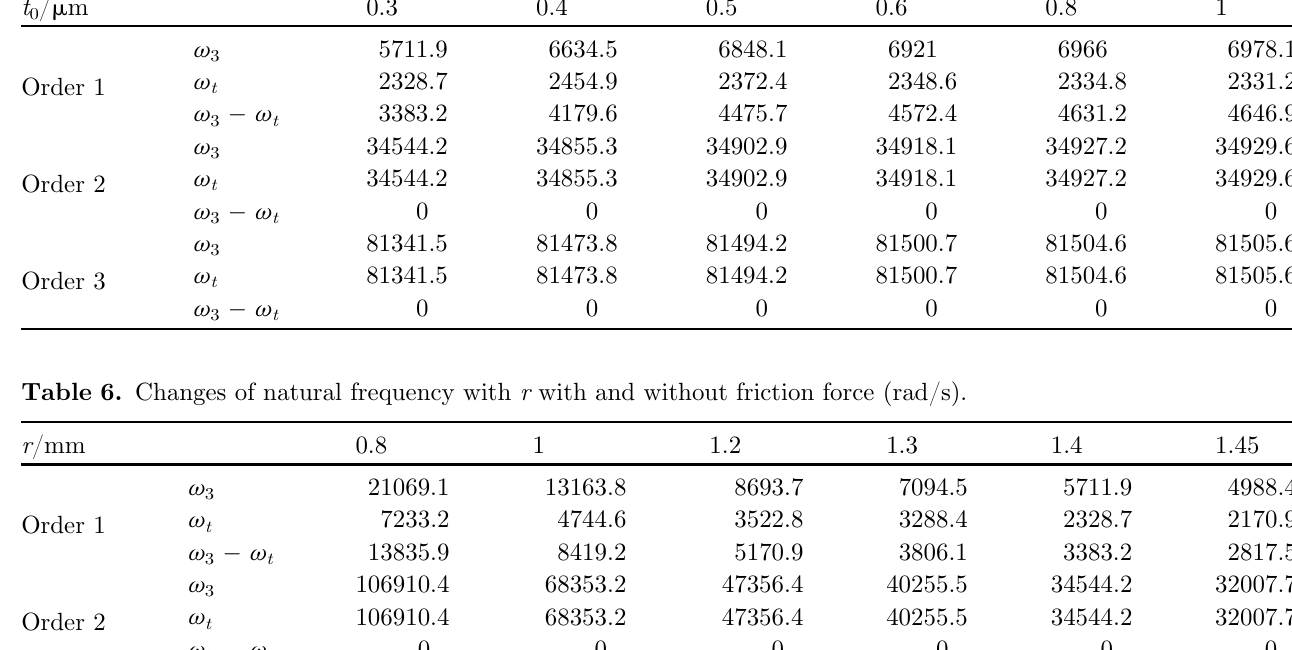
Table 5. Changes of natural frequency with t